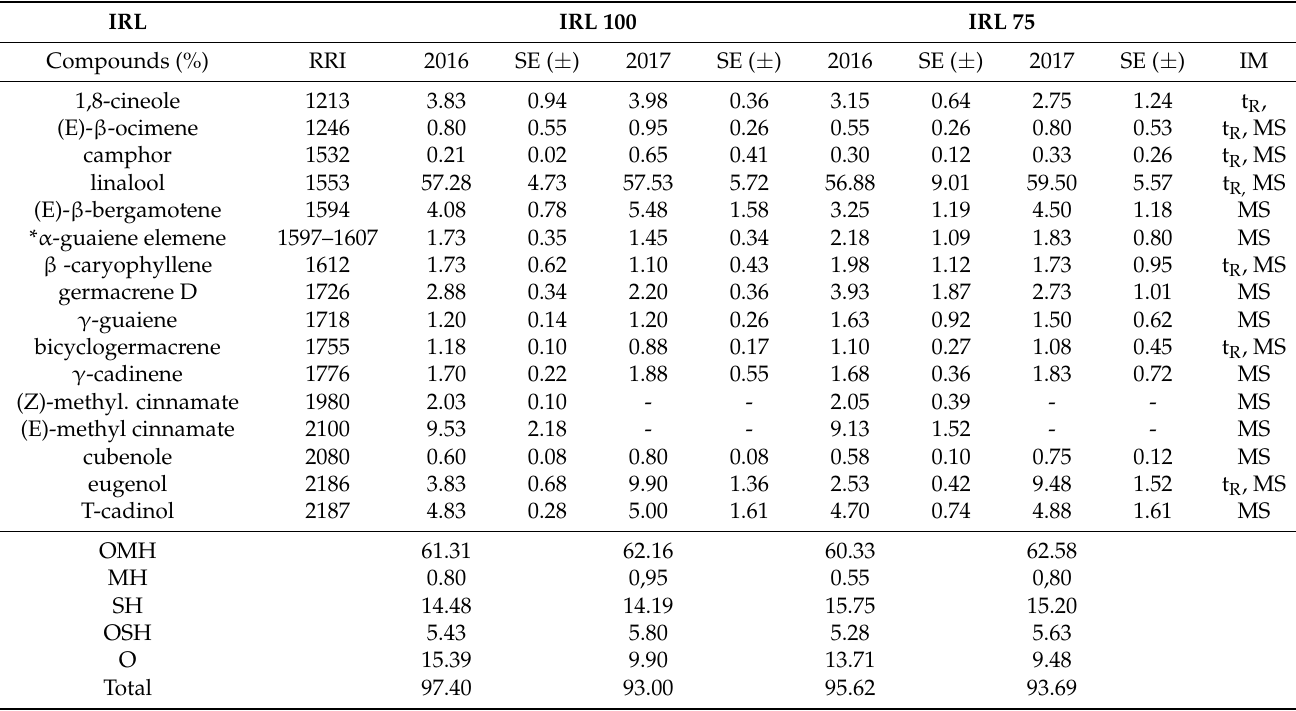
Table 3. Essential oil components of O. basilicum L. according to different IRLs in 2016 and 2017 with- out